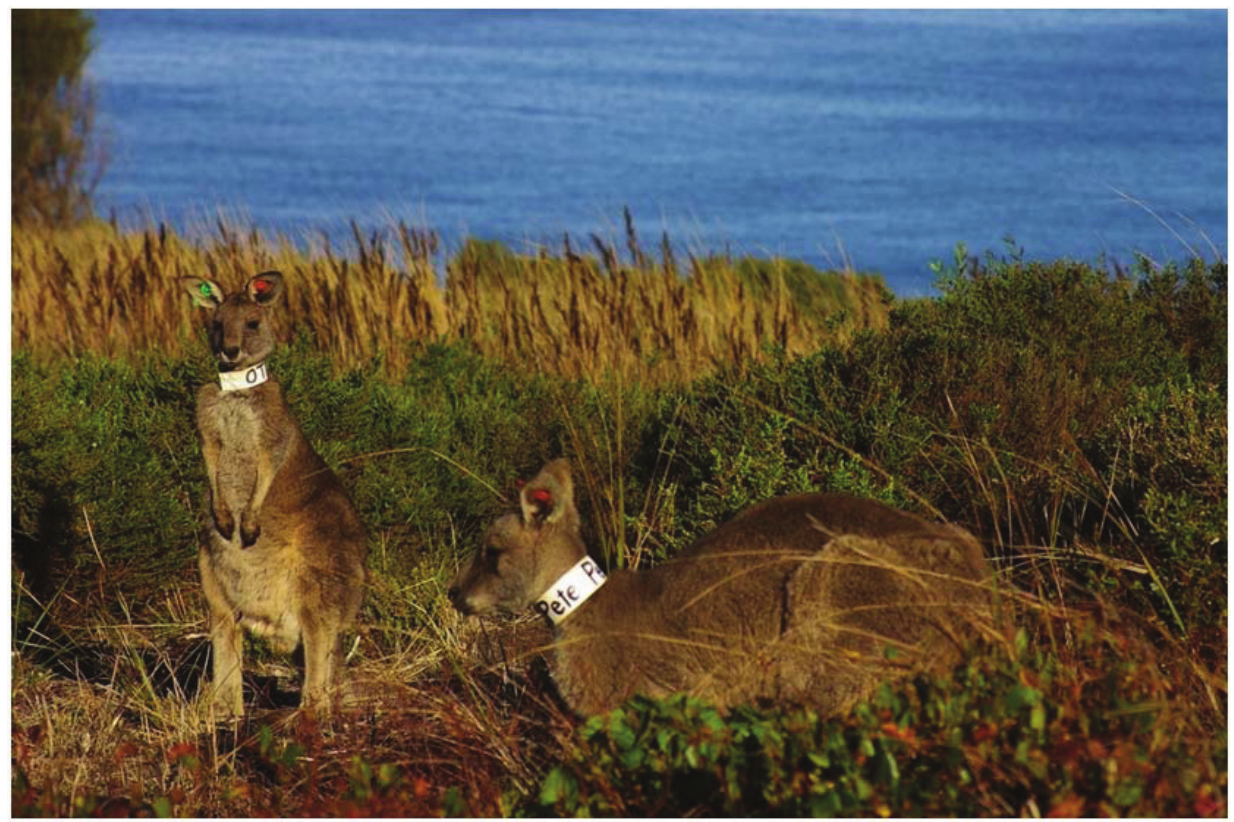
Figure 5. Two tagged and collared male Eastern Grey Kangaroos Macropus giganteus ( Otis and Pete ) at the Anglesea Lookout Flora Reserve above the Great Ocean Road, about 1 km south of where they were collared and tagged at the Anglesea Golf